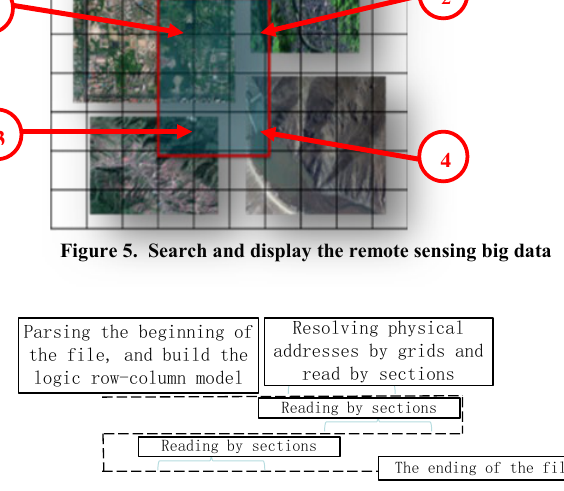
Figure 6. The grid-oriented data dispatch method